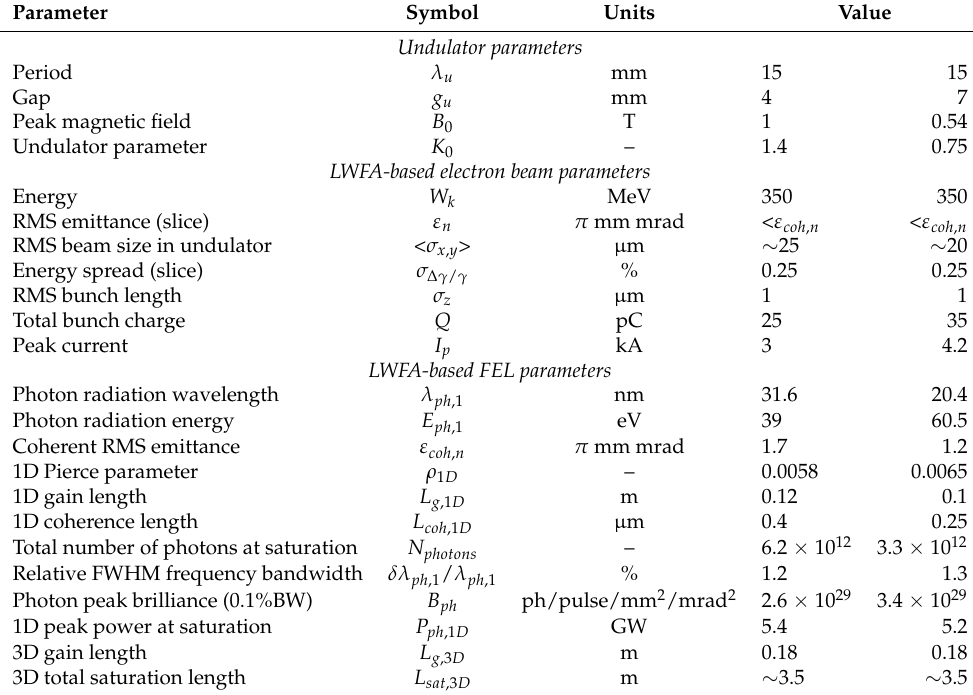
Table 1. Summary of the undulator, electron beam and FEL parameters.